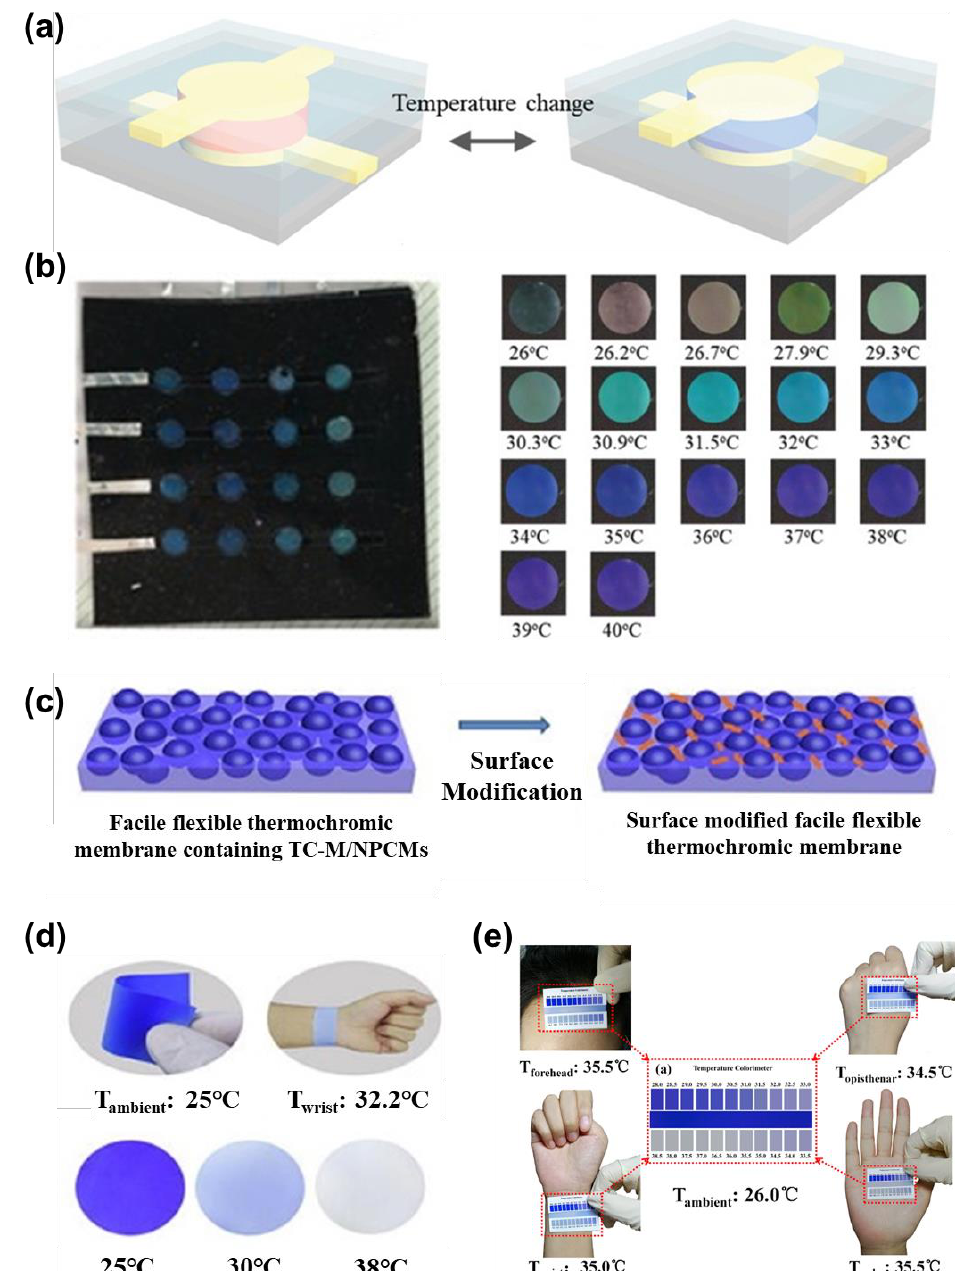
Figure 5. ( a ) Schematic illustration of colorimetric responsibility of optical temperature sensor based on thermochromic liquid crystal (CTL); ( b ) optical image of the sensing unit of wearable temperature sensor at different temperatures (Reprinted with permission from [85]); ( c ) the fabrication process of thermochromic membrane containing TC-M/NPCMs; ( d ) colorimetric response and application of the colorimetric temperature sensor; ( e ) applications of temperature colorimeter in different positions of body surface. (Reprinted with permission from [86]).